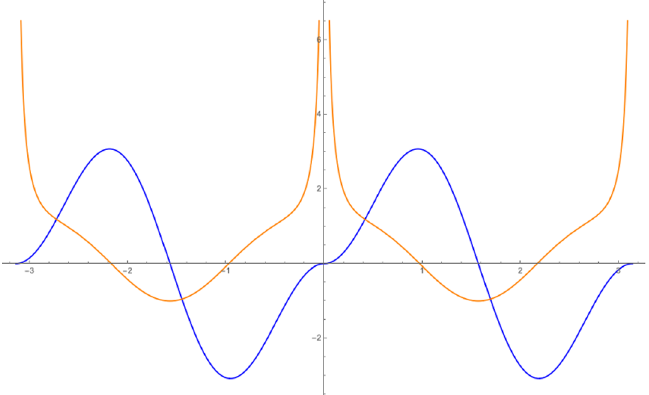
Figure 5 . Eigenmodes of the planar fluctuations on the closed rotating string, with n = 3 . The even mode diverges at the folding points 0 and π , the odd modes vanish